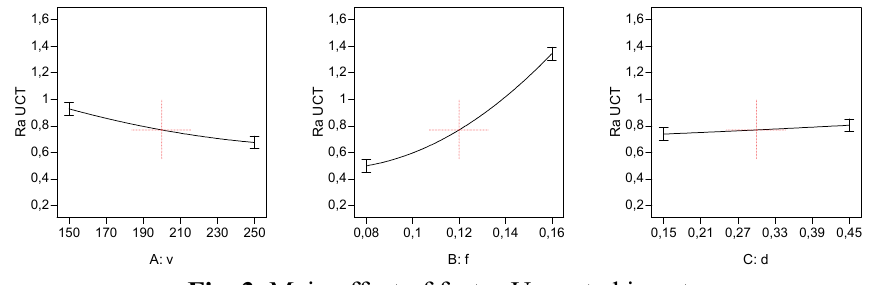
Fig. 3. Main effect of factor Uncoated inserts